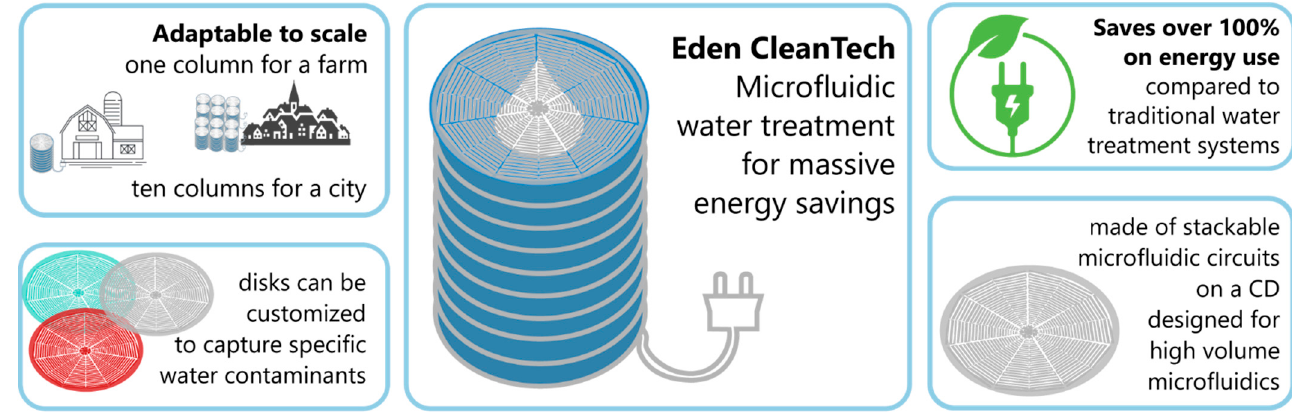
Figure 4. Impact example: Microfluidics (D3) application to produce clean water and recover nutrients at relatively low cost.